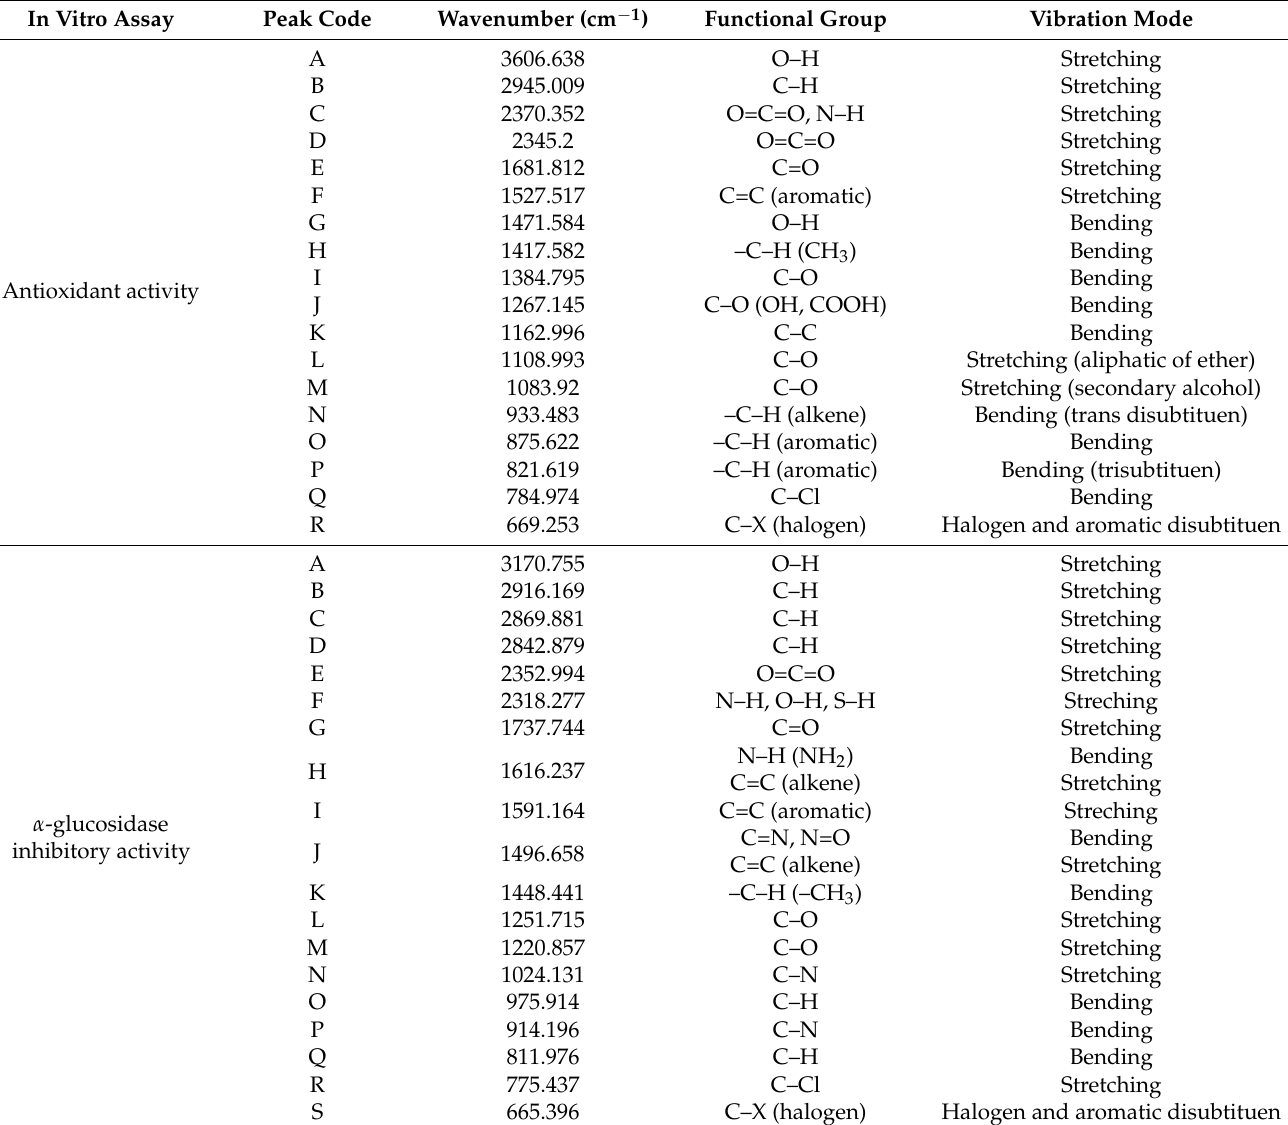
Table 3. The results of partial least squares (PLS) analysis on the wavenumbers, functional group, and vibration mode contribute to the antioxidant and α -glucosidase inhibitory